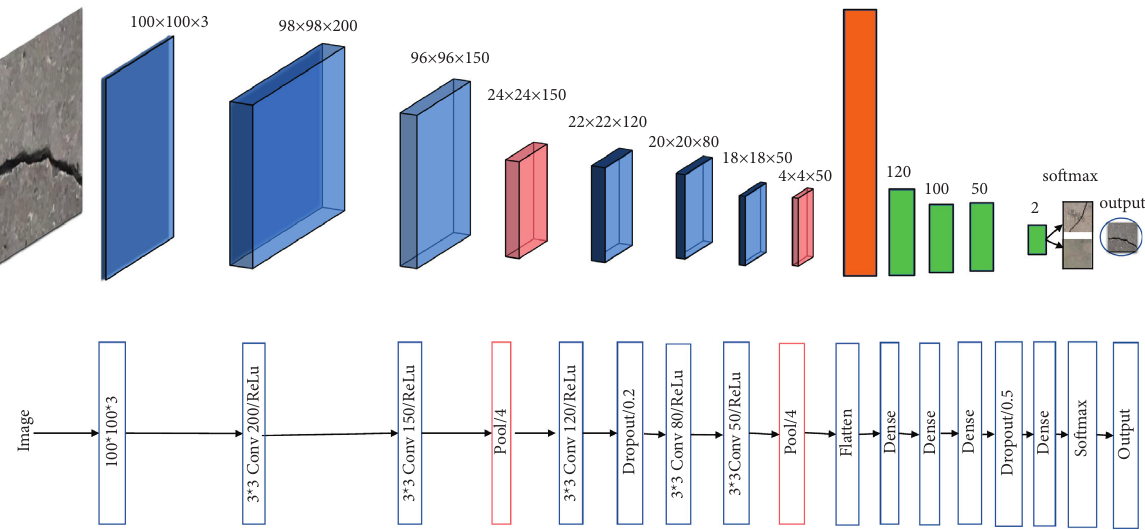
Figure 1: The architecture of Model1.